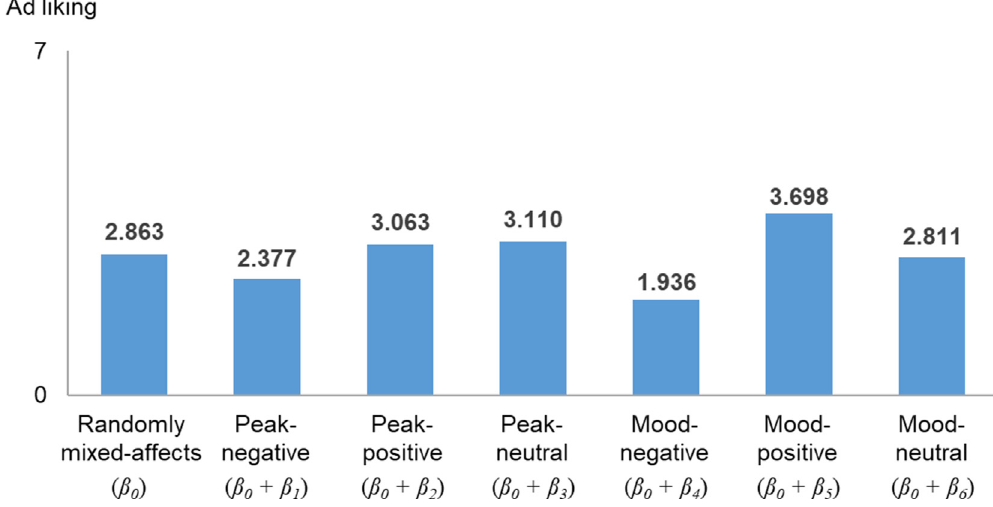
Fig. 2. The net effects of ad